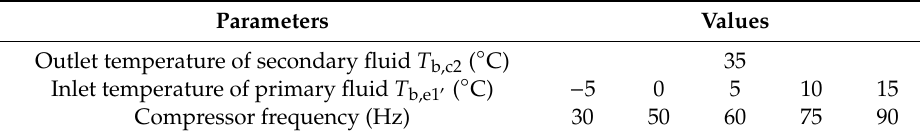
Table 4. Experimental